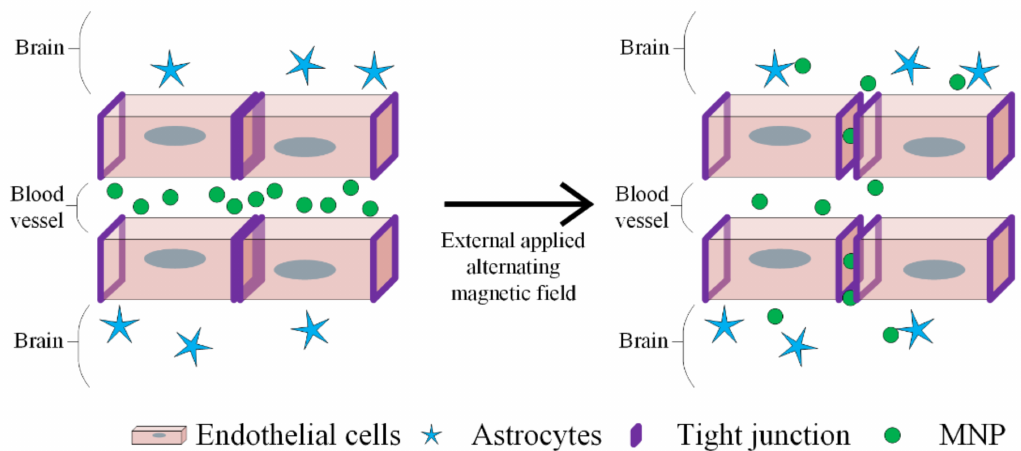
Figure 16. BBB disruption using MNPs and applying an alternative magnetic field. The heat generated by MNPs opens up the tight junction to deliver the drugs. The endothelial cells, astrocytes and MNPs are represented by different symbols, as indicated in the figure